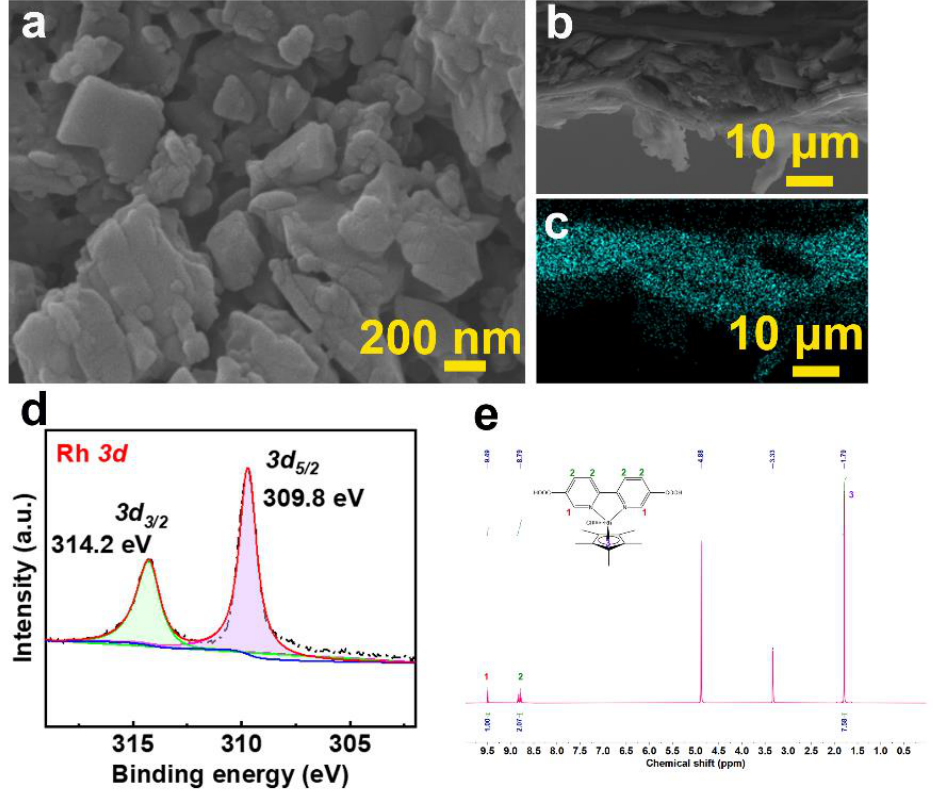
Figure 1. Characterizations of the Rh-complex. ( a ) SEM image of the Rh-complex, ( b ) cross section SEM image and ( c ) elemental mappings of the Rh-complex fixed electrode. ( d ) The Rh 3d XPS spectrum, and ( e ) 1H NMR spectrum of the Rh-complex.